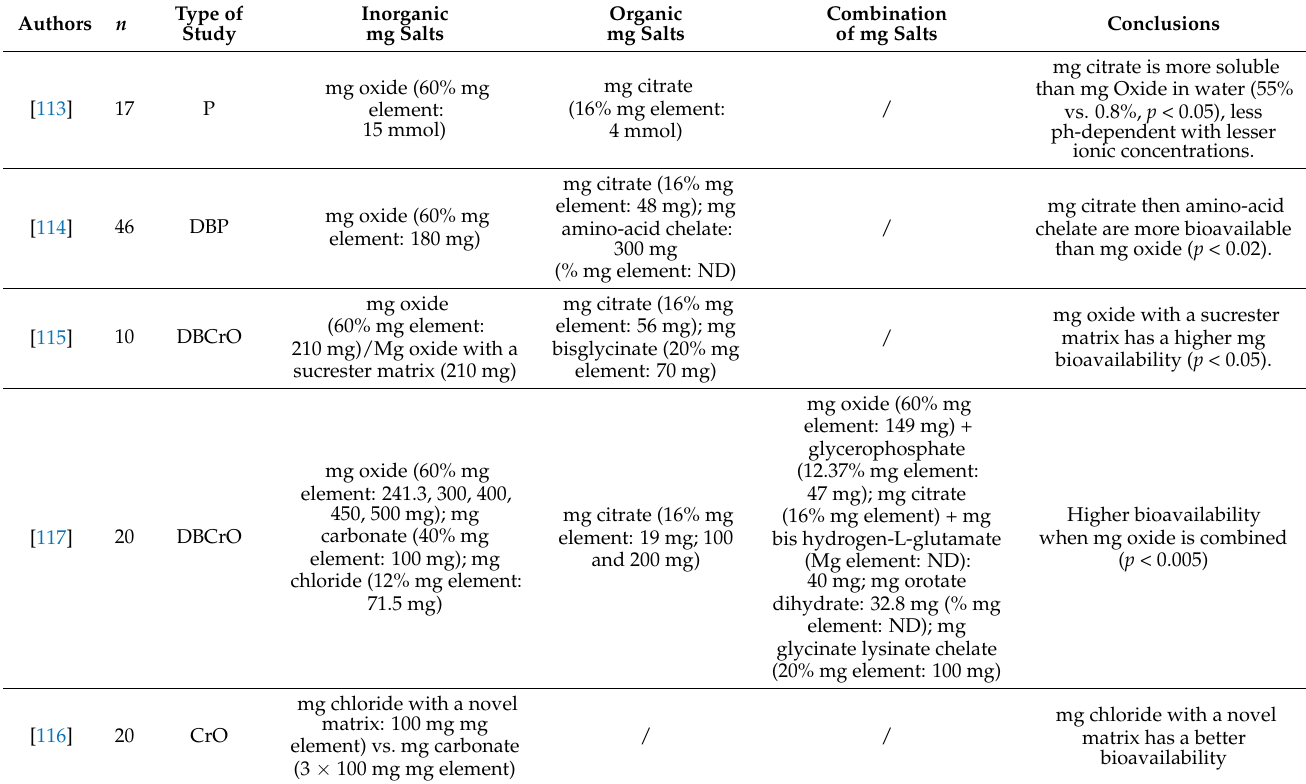
Table 2. Magnesium bioavailability in randomised clinical trials comparing inorganic and organic salts in healthy volunteers ( n = number). DB: double-blind; P: parallel; CrO: